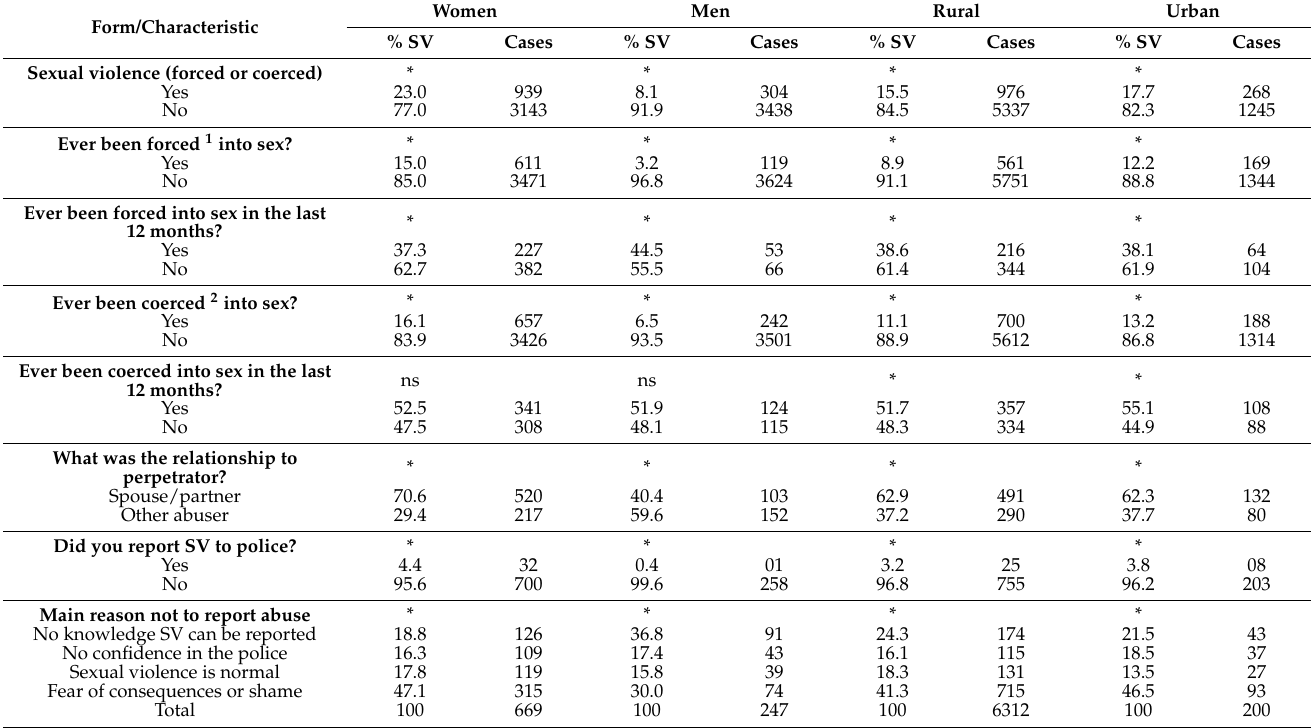
Table 1. Prevalence of sexual violence by forms of violence, UAIS, 2011 ( n =